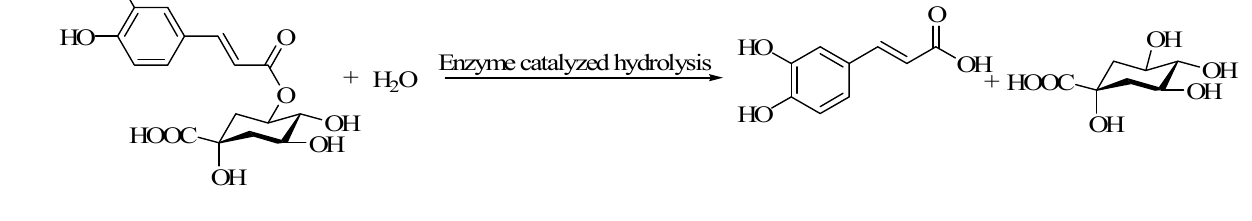
Figure 9. The reaction of enzyme catalytic transesterification.